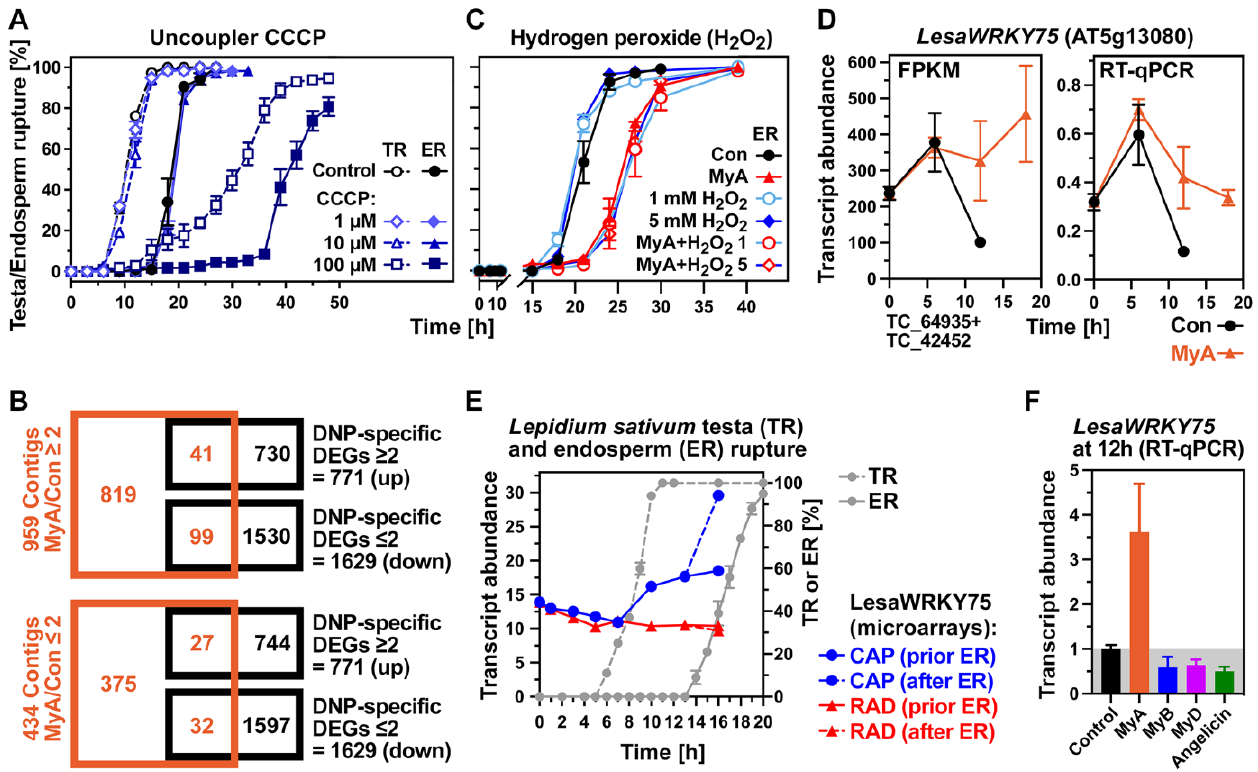
Figure 3. The effects of uncoupler and hydrogen peroxide (H 2 O 2 ) on Lepidium sativum (cress) seed germination and of MyA-induced WRKY75-mediated oxidative signalling. ( A ) Kinetics of testa rup- ture (TR) and endosperm rupture (ER) during cress seed germination without (Control) and with the uncoupler CCPP added in the concentrations indicated. ( B ) Comparison of numbers of differentially expressed L. sativum transcript contigs in MyA-treated seeds with differentially expressed A. thaliana genes in uncoupler (DNP)-treated seeds. ( C ) Kinetics of ER during cress seed germination as affected by MyA (0.5 mM) and H 2 O 2 added in the concentrations indicated. ( D ) Expression patterns of WRKY75 transcripts upon treatment of cress seeds with MyA. ( E ) Spatiotemporal expression pattern of WRKY75 during cress seed germination. ( F ) Relative WRKY75 transcript abundance comparisons of cress seeds treated with MyA or other compounds. Transcript abundance mean ± SEM values of 4–5 (FPKM) and 3 (qRT-PCR) biological replicates are presented.